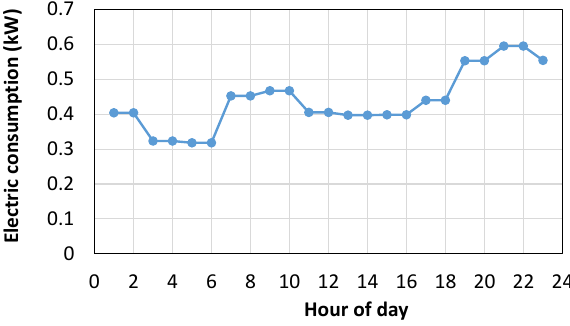
Figure 6. Approximated electricity load profile of other usage for one day (comprising lighting and plug load).